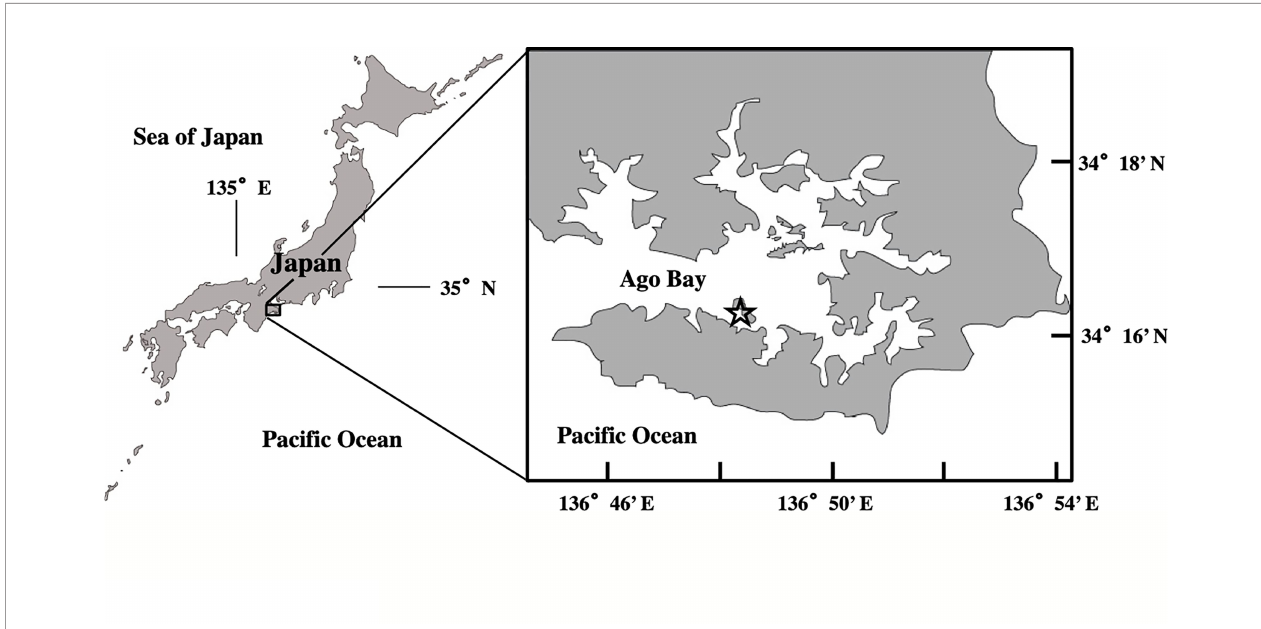
FIGURE 2 | Location of the sampling site (open star) in Ago Bay, central